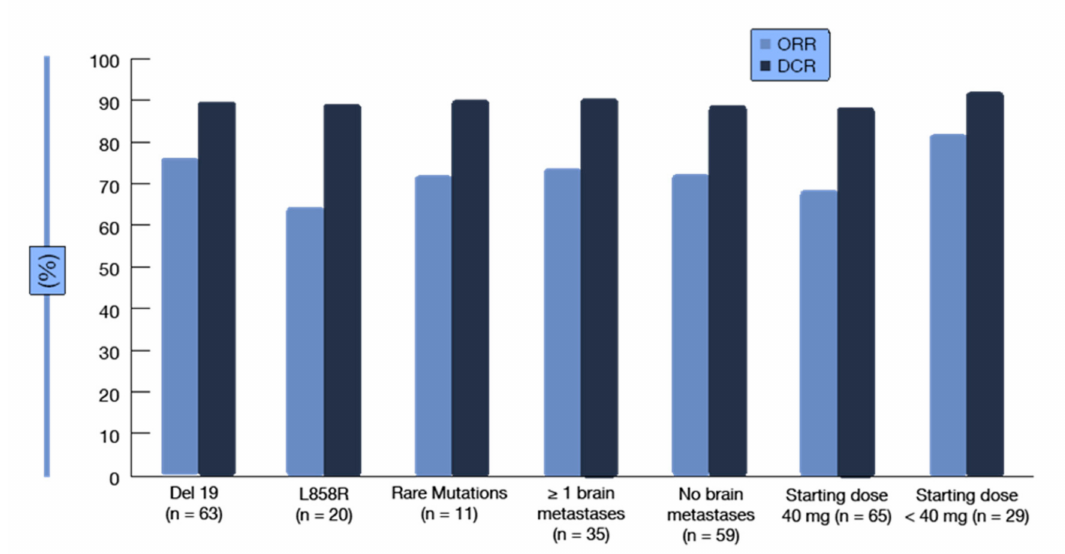
Figure 6. Overall response rates and disease control rates obtained with first-line afatinib in the noninterventional GIDEON study [59] (adapted from Brueckl et al., ESMO, 2018).